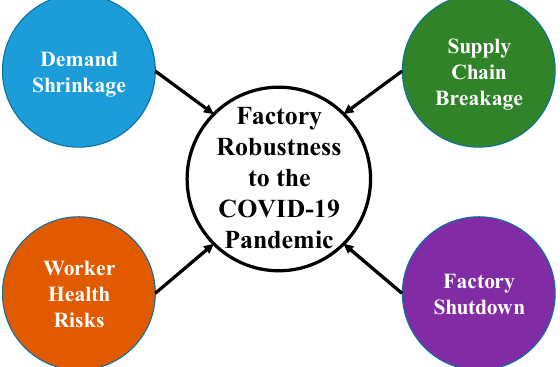
Figure 1. Factors affecting the robustness of a factory to the COVID-19 pandemic. Figure 1. Factors a ff ecting the robustness of a factory to the COVID-19 pandemic. Healthcare 2020 , 10 , x FOR PEER REVIEW